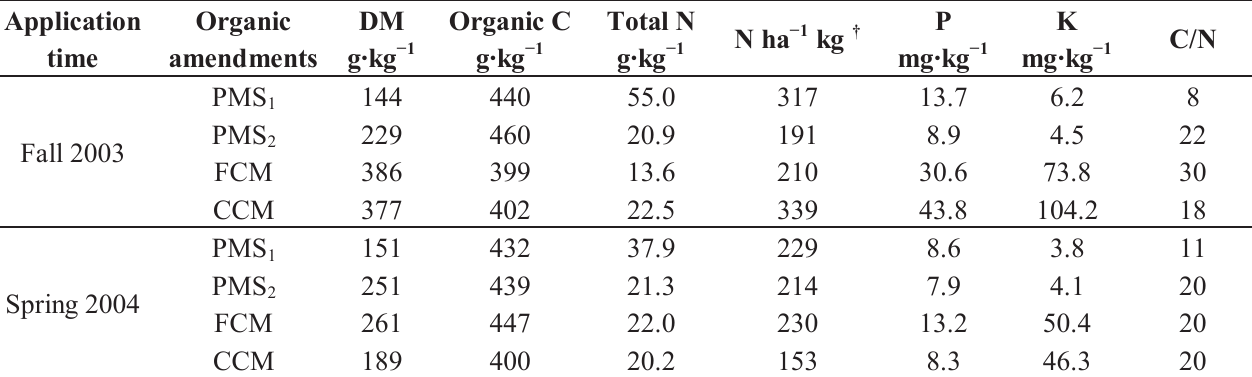
Table 1. Physical and chemical properties * of organic amendments applied in fall 2003 and in spring